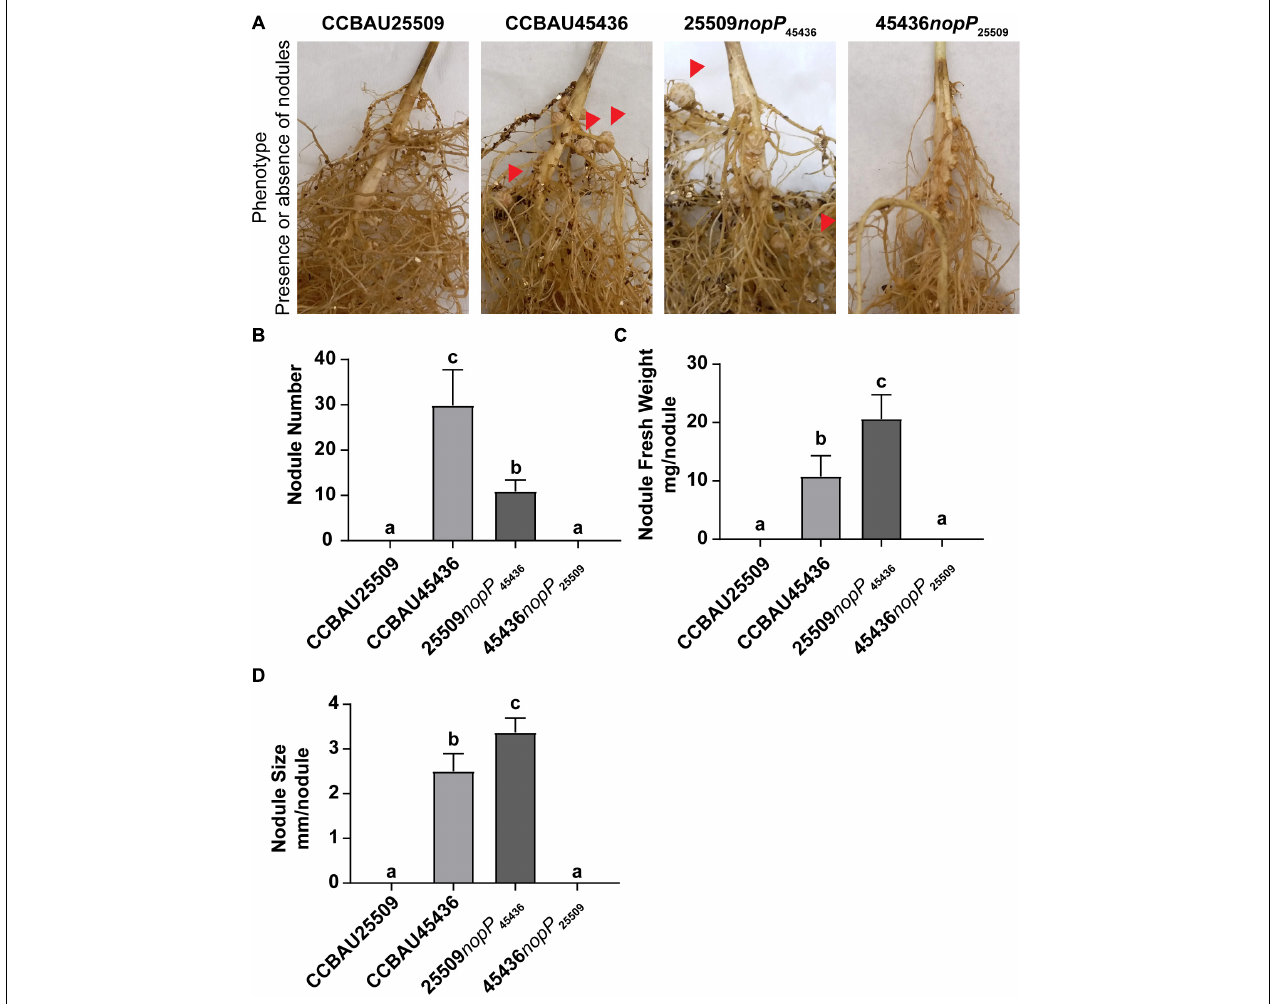
FIGURE 7 | Nodulation phenotype of S. fredii strains carrying different NopP alleles. (A) Root of G. max C08 inoculated with wild type S. fredii CCBAU25509, wild type S. fredii CCBAU45436, mutant of CCBAU25509 carrying NopP from CCBAU45436 (25509 nopP 45436 ), and mutant of CCBAU45436 carrying NopP from CCBAU25509 (45436 nopP 25509 ). C08 carries the rj2/Rfg1 allele. Red arrows indicate some effective nodules formed on the roots. (B) Nodule number, (C) Nodule fresh weight and (D) Nodule size of the nodules harvested from the inoculated roots 28 days post-inoculation. N = 8. Error bar: standard deviation. Different letters above the bars indicate the results are statistically different at p < 0.05. The experiment has been repeated twice with consistent results ( Supplementary Figure S10